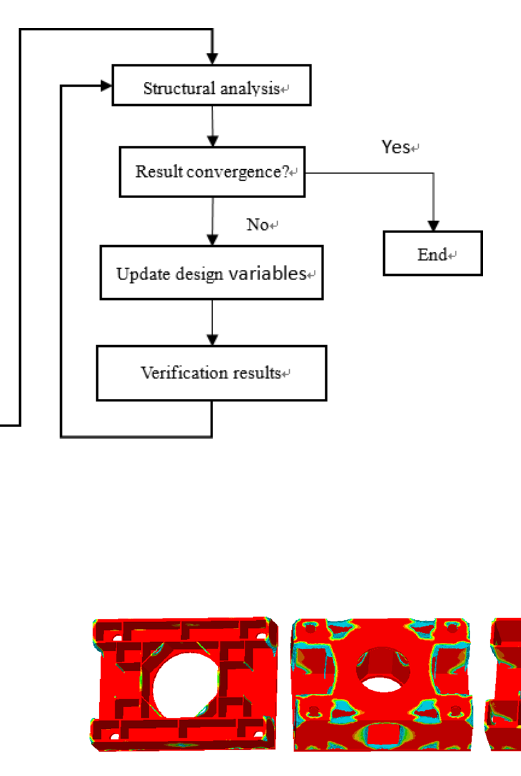
Figure 14. Optimized density diagrame of main optimization area.